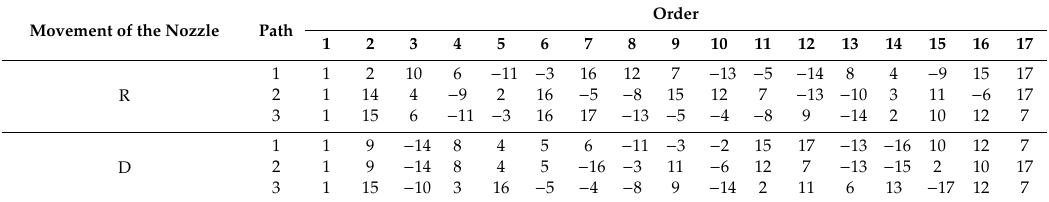
Table 13. Best solutions obtained for the 17-wall component. T = 12.